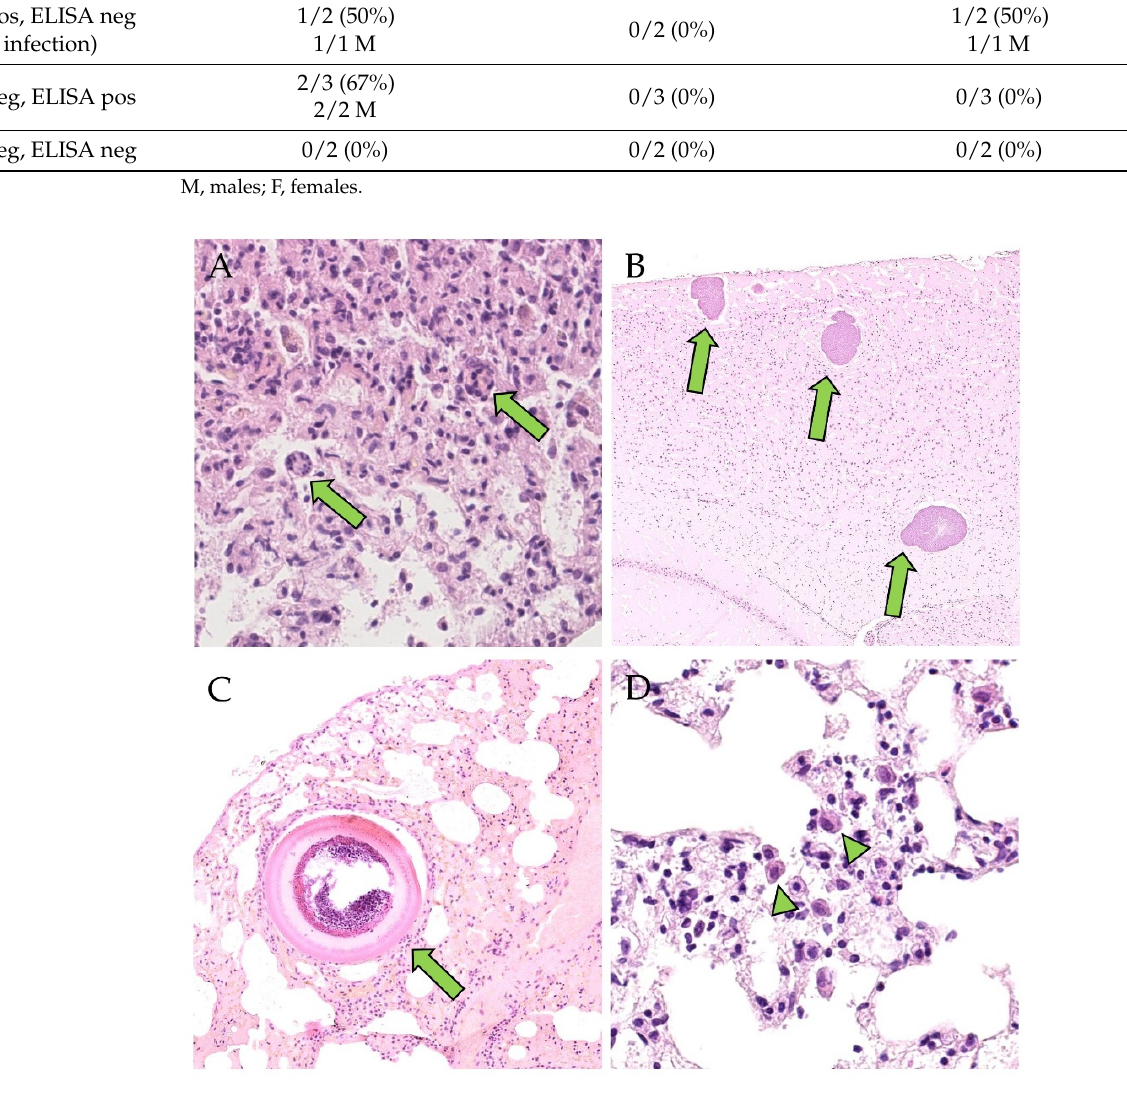
Figure 3. Endoparasites and fungal infection of OS bank voles (H&E). ( A ): male, RNA-negative, antibody-positive, lung: schizonts of Hepatozoon spp. (green arrows); ( B ): male, RNA-positive, antibody-positive, brain (cerebrum): cysts of Sarcocystis spp. without associated inflammation (green arrows); ( C ): female, RNA-positive, antibody-positive, lung: Emmonsia crescens (green arrow); ( D ): female, RNA-positive, antibody-positive, lung: desquamated alveolar macrophages (green arrowheads). Total magnification: ( A , D ): 400 × , ( B ): 40 × , ( C ): 100 ×